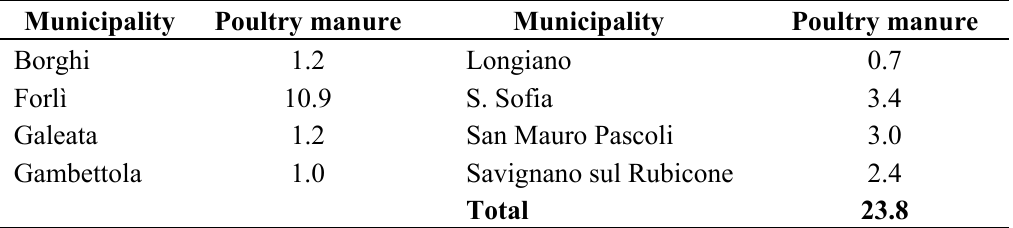
Table 7. Residual poultry manure to be disposed of (in Gg